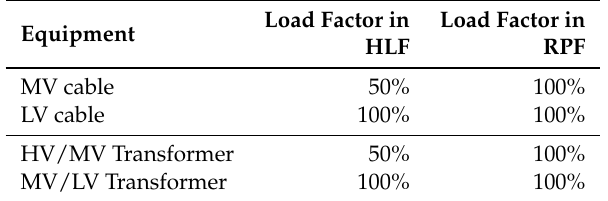
Table 3. Allowed equipment load factors used to identify thermal overloading [31].